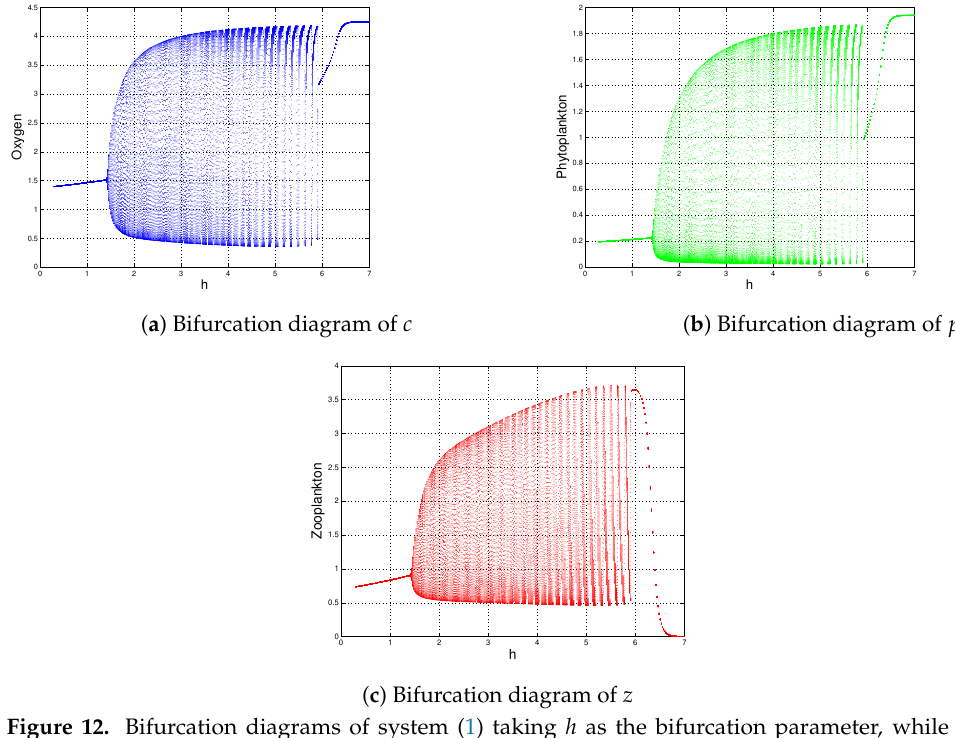
Figure 12. Bifurcation diagrams of system (1) taking h as the bifurcation parameter, while the others remain unchange,d as in Figure 6. Here, (cid:98) E ( (cid:98) c , (cid:98) p , (cid:98) z ) is stable when h ∈ ( 0.0, h [ H ] 1 = 1.442503 ) ∪ ( 5.917323, h [ tc ] = 6.434018 ) and unstable with a periodic solution when h ∈ ( 1.442503, h [ H ] 2 = 5.917323 ) . Again, (cid:98) E ( (cid:98) c , (cid:98) p , (cid:98) z ) goes to stable zooplankton free equilibrium E 1 ( (cid:101) c , (cid:101) p ,0 ) when h > h [ tc ] =